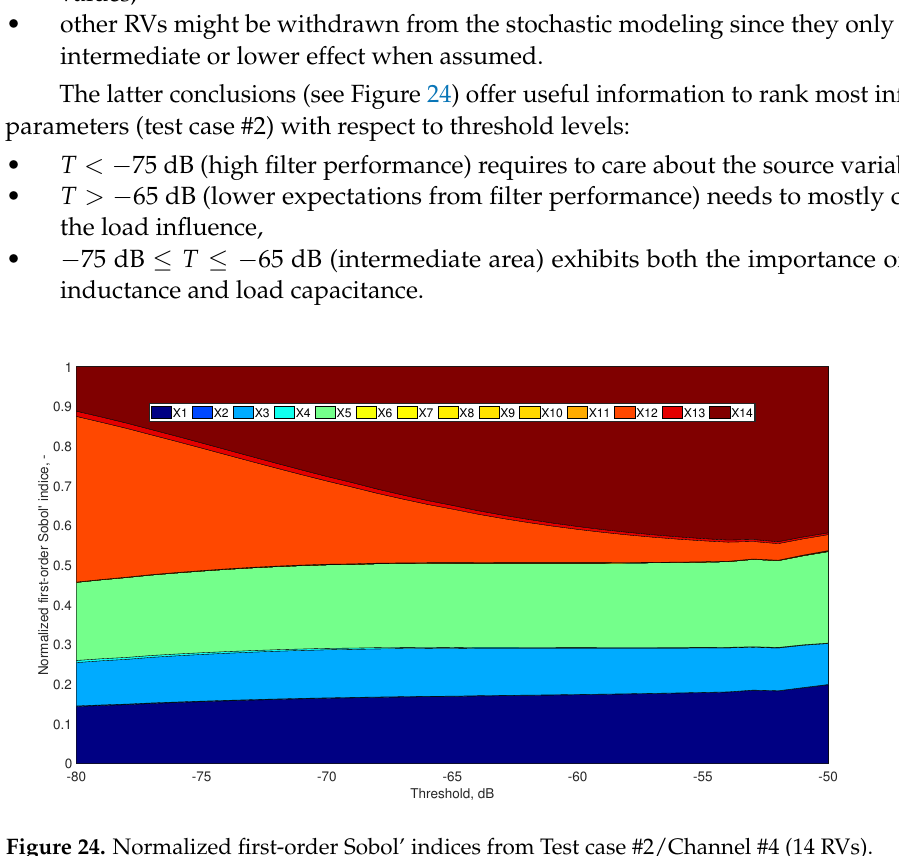
Figure 24. Normalized first-order Sobol’ indices from Test case #2/Channel #4 (14